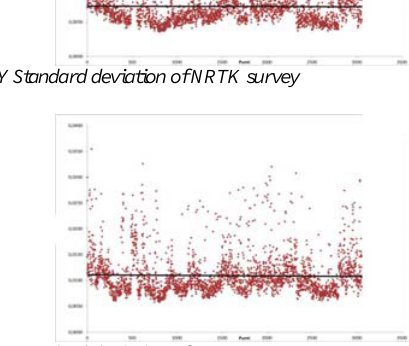
Fig.2: Y Standard deviation of NRTK survey